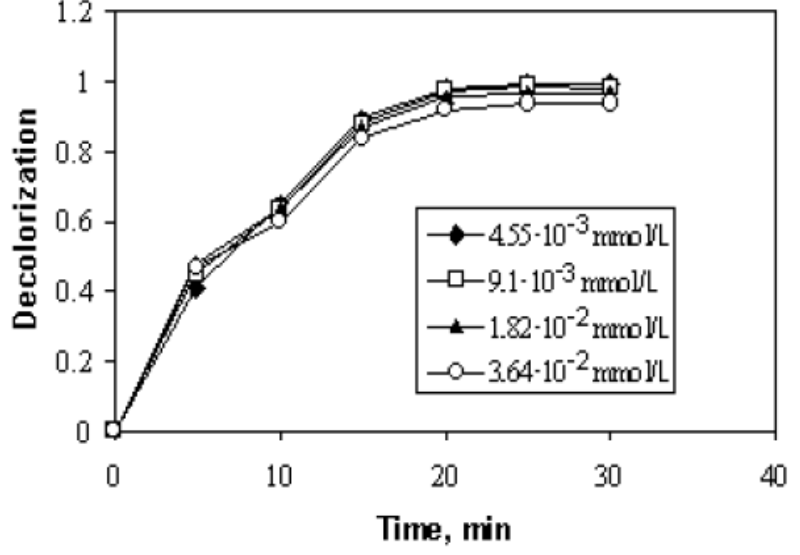
Fig. 18 Effect of Mn 2+ ions on AOP in alkaline medium. Initial conditions: C dye =50 mg/L, [H 2 O 2 ]= 17.318